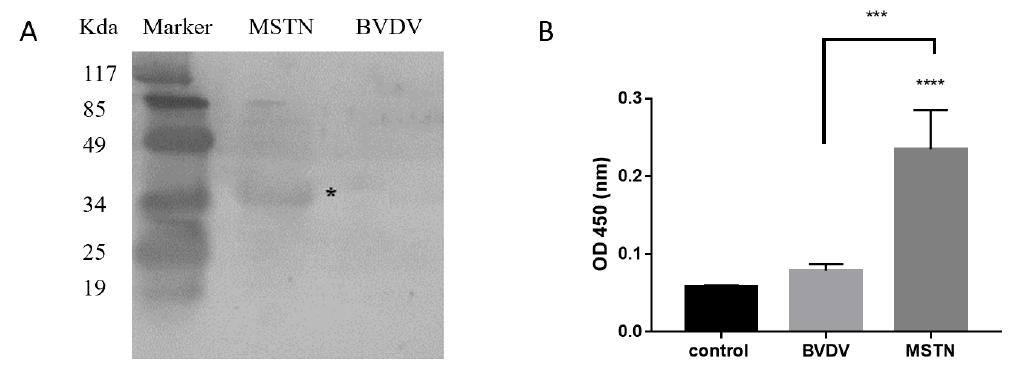
Figure 1. Specific activity of recombinant MSTN nanobody (RMN). ( A ) Western blot showed a specific band at 32 kDa after the recombinant Myostatin (MSTN) protein reacted with RMN (white star). ( B ) The ELISA showed that the RMN was combined with MSTN protein. PBS coating set as control. *** p < 0.001; **** p < 0.0001, statistical analysis was performed with one-way ANOVA with Dunn’s test for multiple comparison.